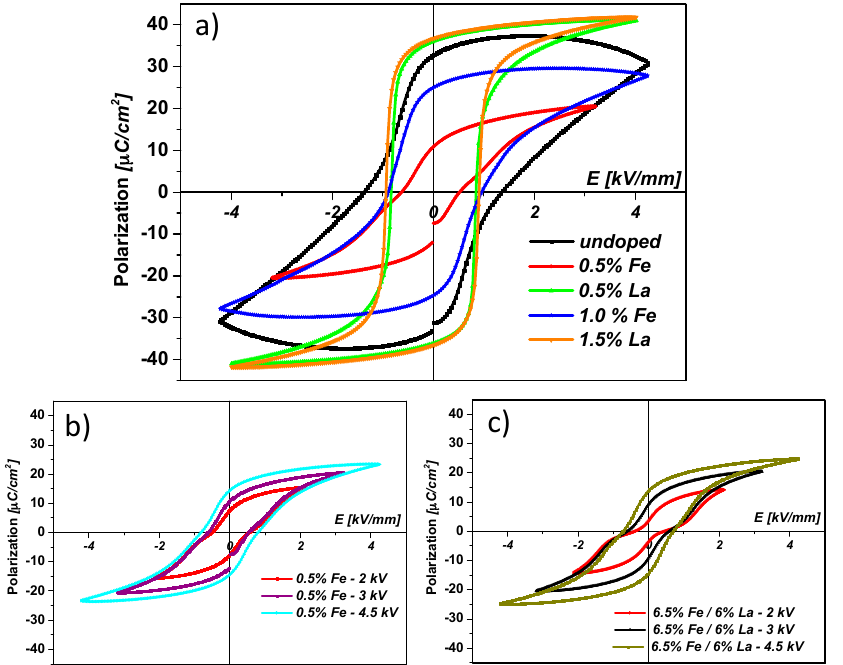
Figure 13. ( a ) P–E curves of different PZT samples (see legend). La-doped samples develop slim P–E curves with increased polarization. Fe-doped samples develop inclined P–E curves with reduced maximum polarization; ( b ) P–E curves of a sample doped with 0.5 mol % Fe measured for different maximum electric fields (see legend). Pinching of the P–E curve at low field amplitude indicates domain wall pinning, which is typical for acceptor-doped samples; ( c ) P–E curves of a sample doped with 6 mol % La and 6.5 mol % Fe measured for different maximum electric fields (see legend). Again the pinching of the P–E curves at low field amplitude indicates net acceptor doping of the sample.